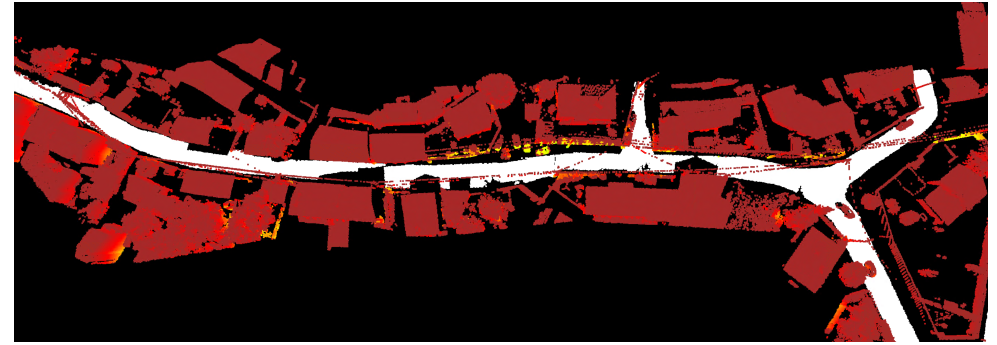
Figure 13. Height above in most detailed scale, KNN = 25.